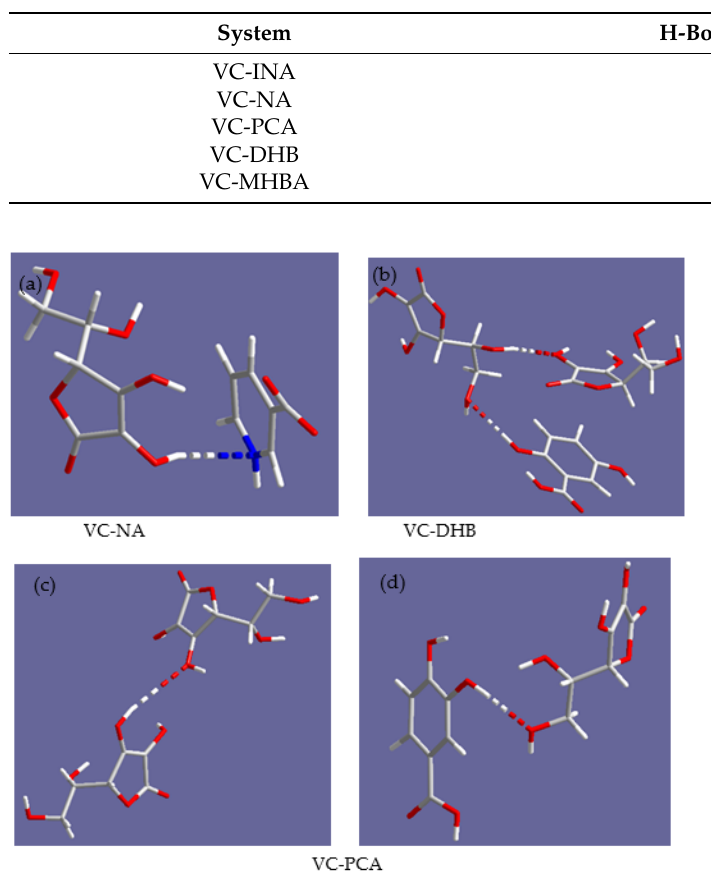
Figure 2. ( a ): VC-NA, ( b ): VC-DHB, ( c , d ): VC-PCA, ( e , f ): VC-MHBA. Probable interactions between VC and CCFs. All the molecules are represented with wires and sticks; C, H, O and N are repre- sented by gray, white, red and blue, respectively. 2.3. Thermal Analysis The thermal behavior of the co-crystals was determined by TG and DSC, and ascorbic acid and CCFs were used as the reference. As shown in Figure 3, ascorbic acid and the CCFs had different endothermic peak positions compared to the co-crystals, which was indicative of distinct thermal behavior. The TG and DSC curves showed that all the co- crystals except for VC-PCA are free from crystalline water or solvents in the lattice and began to decompose at approximately 189 °C, 184 °C, 174 °C and 176 °C for VC-INA, VC- NA, VC-DHB, VC-MHBA, respectively (Figure 3). The values are all lower than VC or CCFs, and the phenomenon is consistent with the majority of co-crystals. The DSC curve